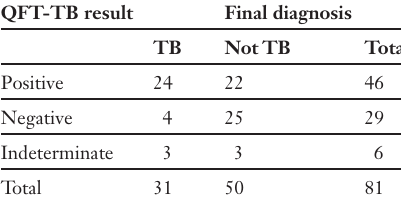
QFT-TB Gold result in comparison with responding of treatment.